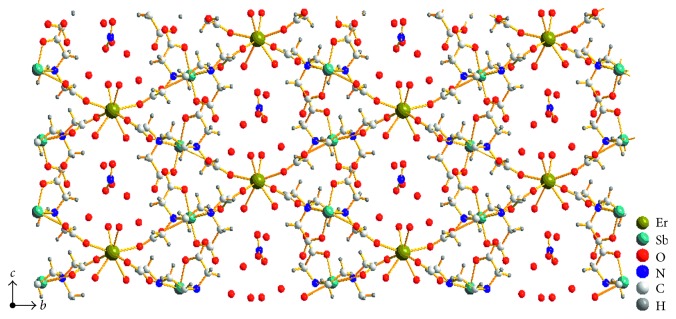
A view of the two-dimensional layer of the complex parallel to the (1 0 0) plane.